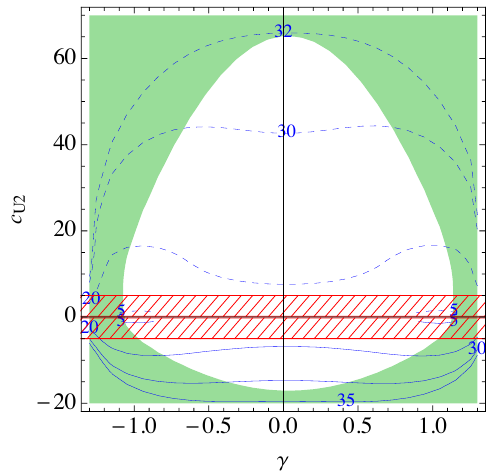
Figure 5 . Region excluded at 95%CL in a global (cid:12)t of bs(cid:22)(cid:22) clean observables and the other d i d j (cid:22)(cid:22) ones listed in table 4, assuming the structure of eq. (4.3), in the plane ( (cid:13); c U 2 ). The relevant observable in the excluded region is K L ! (cid:22) + (cid:22) (cid:0) . The range j c U 2 j 2 [0 : 2 (cid:0) 5] is highlighted as the meshed red region. Blue lines indicate the size of the overall coe(cid:14)cient j C L j (cid:0) 1 = 2 (in TeV), as extracted from the (cid:12)t. Solid (dashed) lines are for positive (negative) values of C L . exchange dominates FCNC processes, the SM itself satis(cid:12)es the ROFV condition, with ^ n = ( V (cid:3) ; V (cid:3) ; V (cid:3) ) also in the form ts td tb